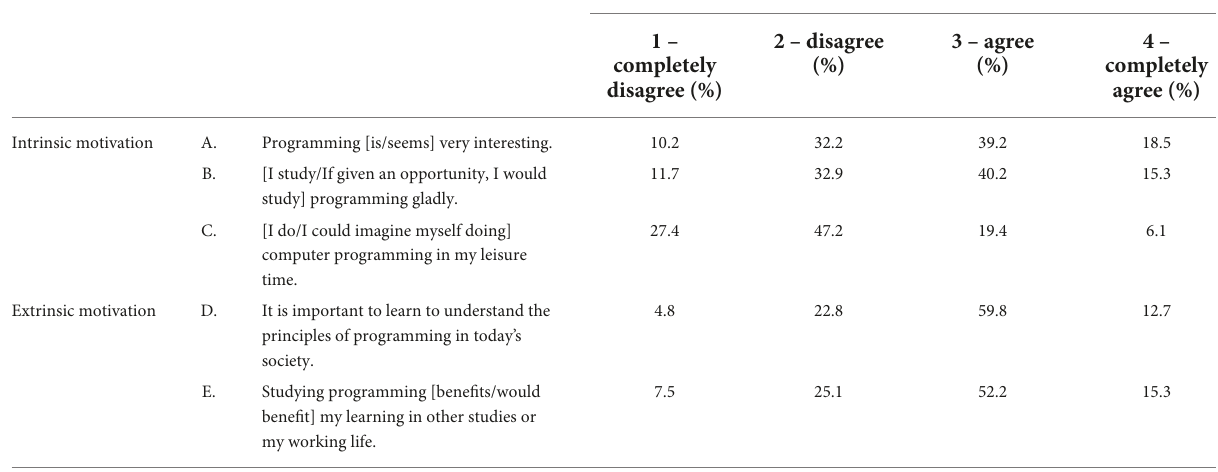
TABLE 8 Descriptive statistics of students’ programming motivation.